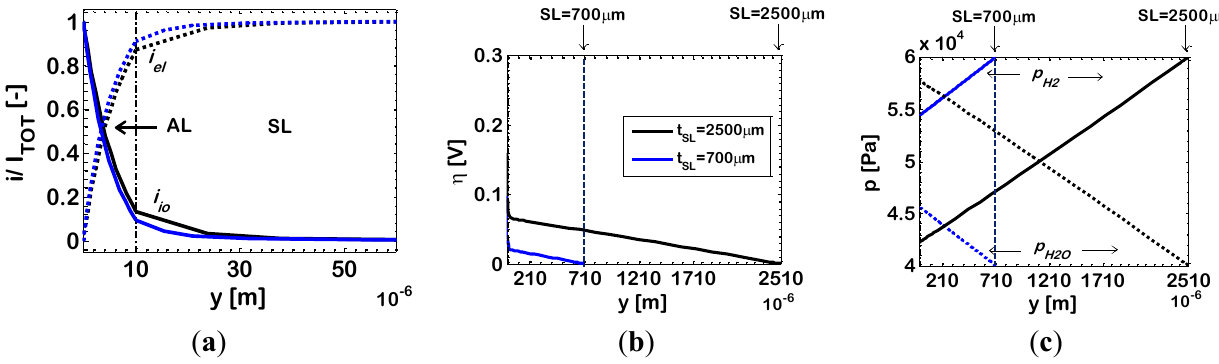
Figure 10. Bi-layered Ni-YSZ anodes at temperature T = 1073 K; Ni volumetric fraction in the AL ϕ = 0.44 (Case 2 ). Other data reported in Table 2. Varying parameter: SL el,AL c thickness ( t ). Simulated distributions along the electrode thickness of: ( a ) ionic ( i SL electronic ( i ) currents; ( b ) overpotential (η); and ( c ) partial pressures of hydrogen ( p el and water ( p H2O